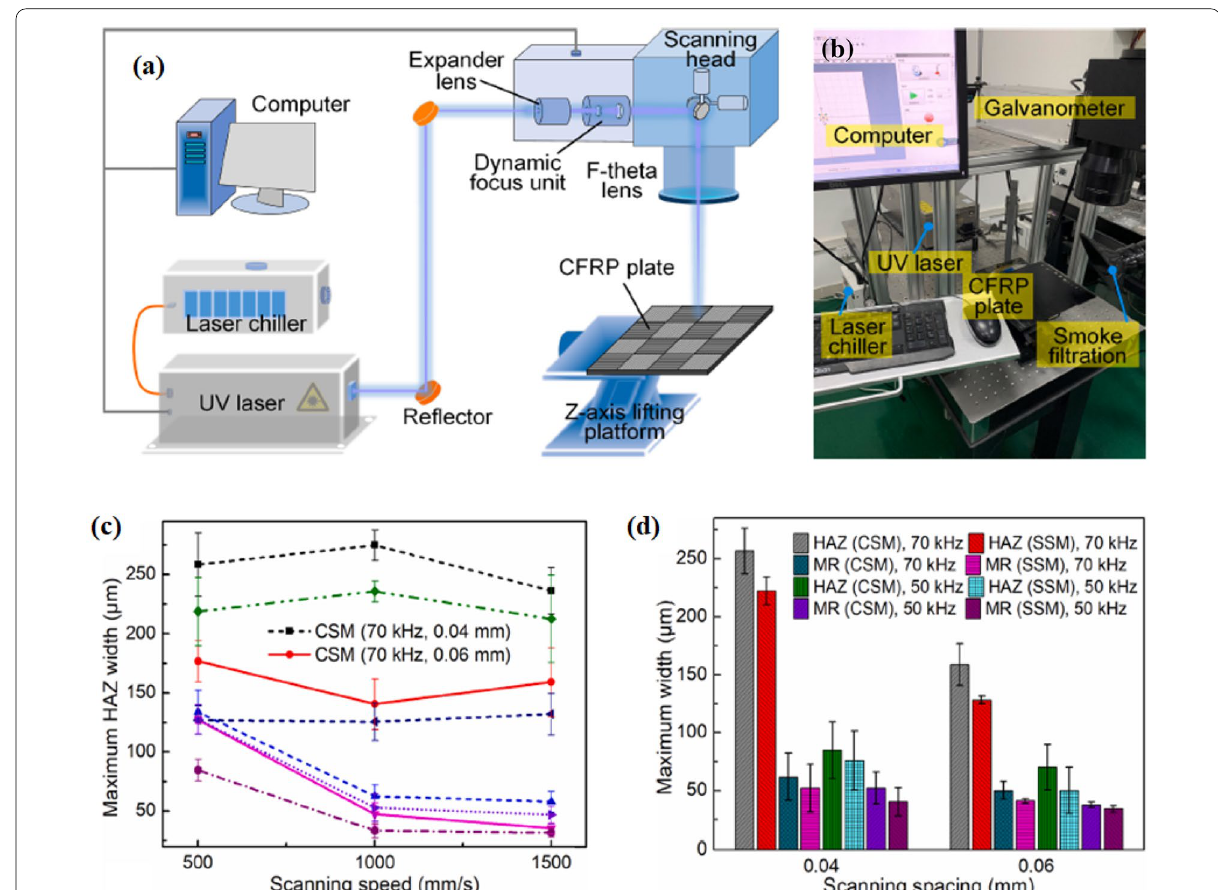
Figure 29 Effect of laser drilling on HAZ: a The schematic diagram of laser drilling system, b Experiment setup of laser drilling system, c Effect of scanning speed on HAZ under CSM and SSM, d Effect of scanning spacing on HAZ and MR under CSM and SSM